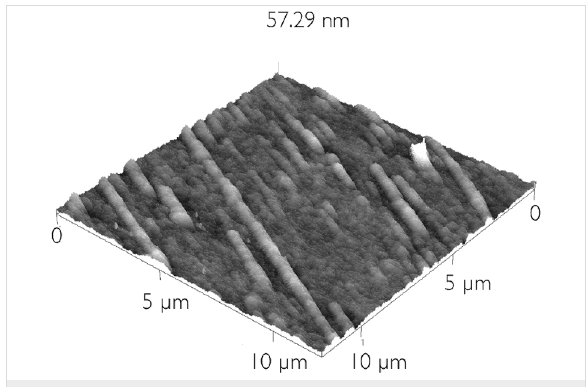
Figure 4: Thinner, isolated fibers, similar to the ones constituting the larger rope in Figure 3 are present in other areas of the